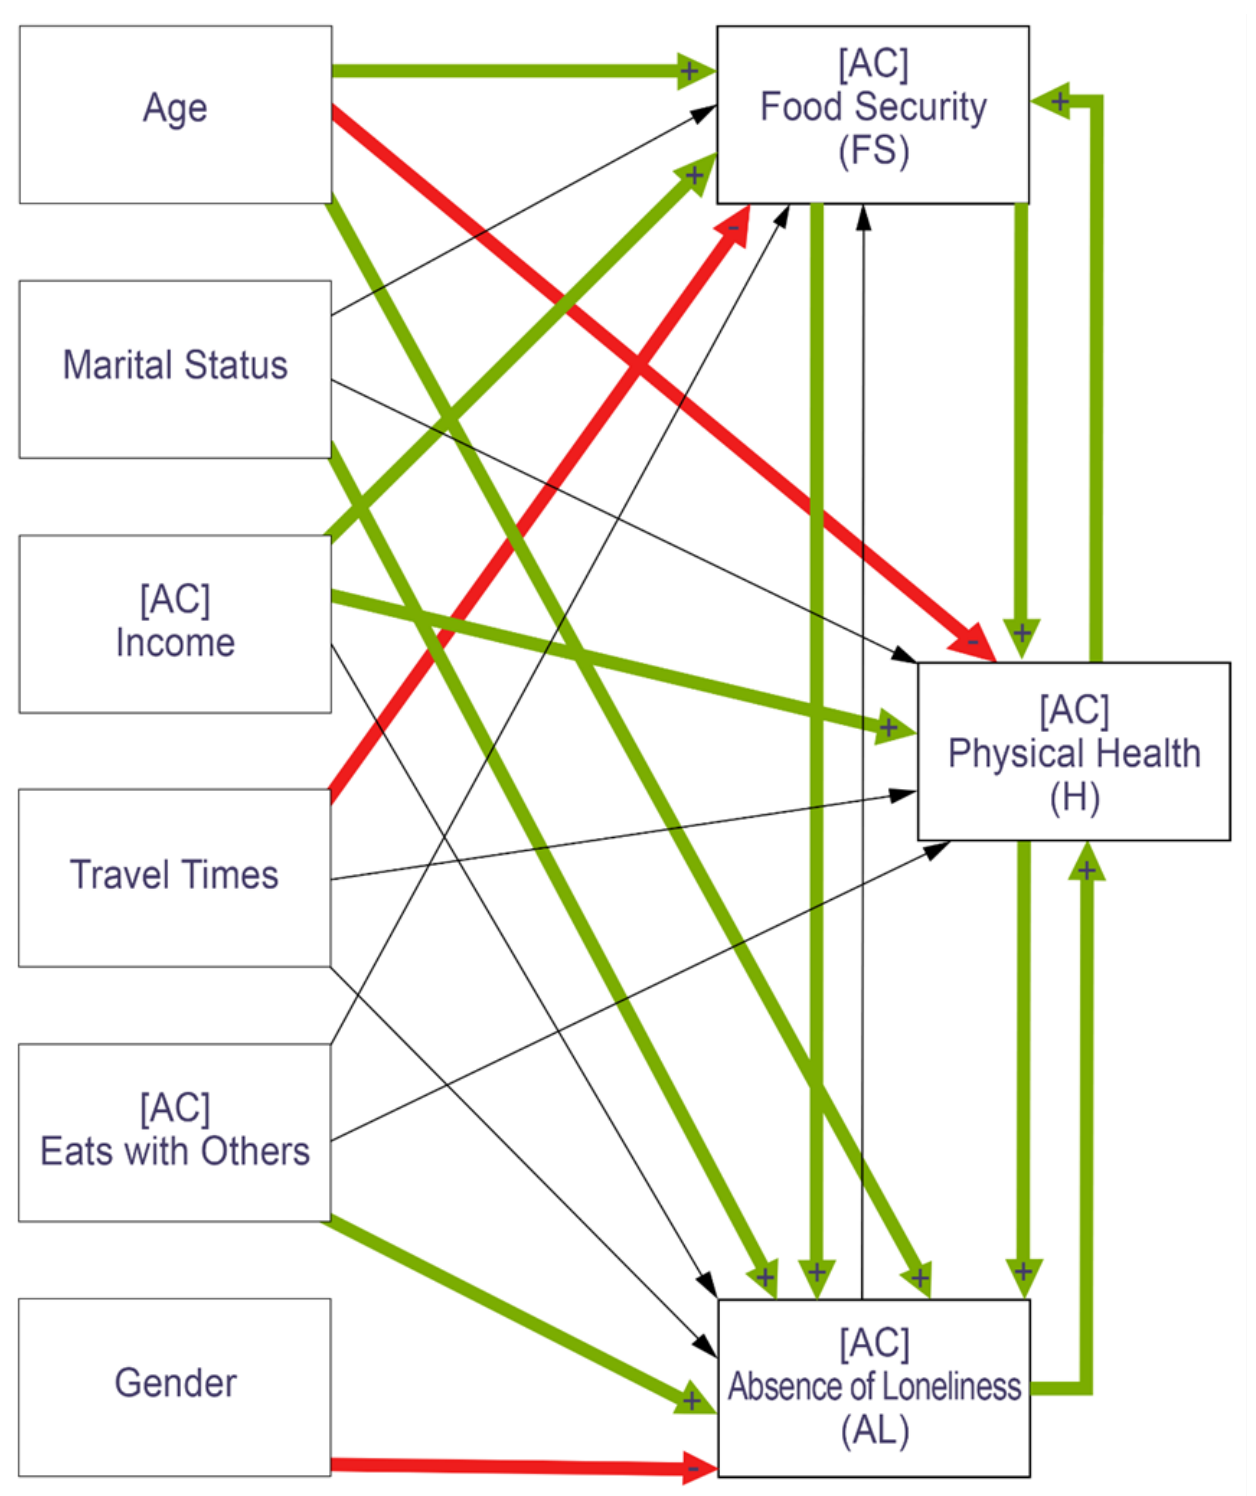
Figure A1. Path analysis for after the onset of the pandemic. Thin lines represent insignificance. Thick lines represent significance at α = 0.05. Green represents positive relationships and red negative relationships.